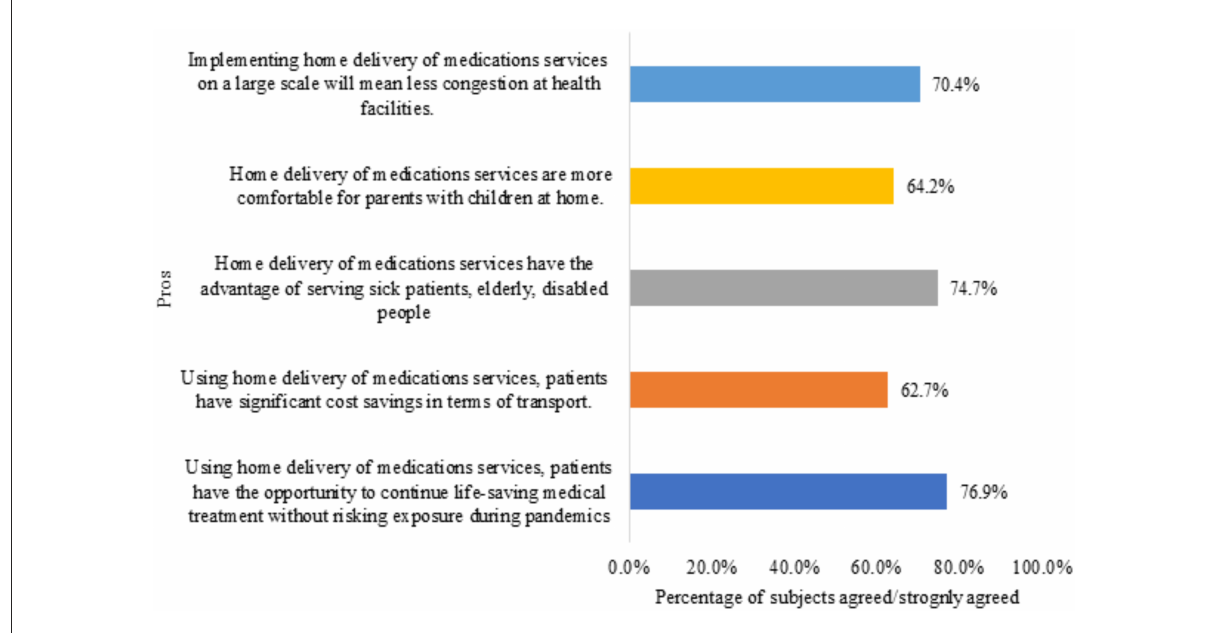
FIGURE1 Participants’ perception of the pros of home delivery of medication service ( n = 324).